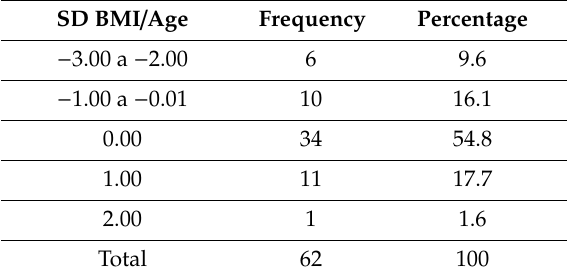
Table 4: Table 4. Percentage Distribution of Children Older than 5 Years Evaluated, in Relation to the SD BMI /